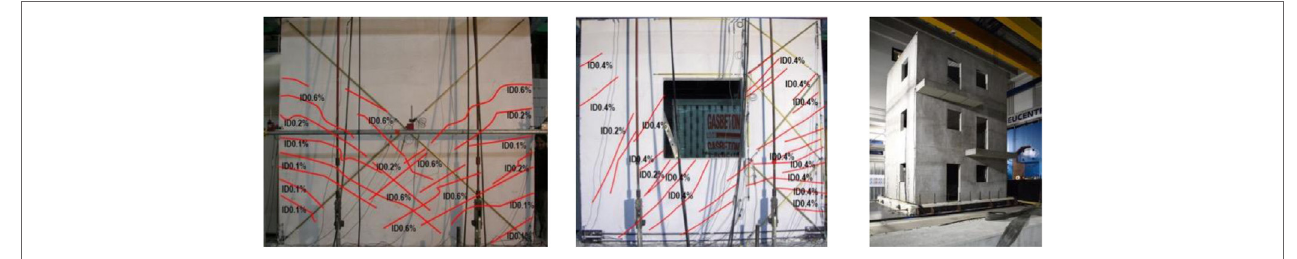
FigURe 12 | From the left: typical cracking patterns for a full panel and for a perforated panel; the prototype building tested on the shaking table at the Eucentre lab.